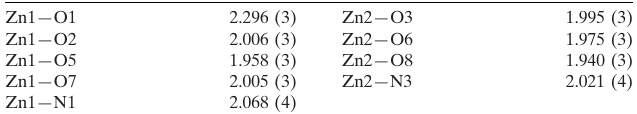
37814 measured reflections 10696 independent reflections int = 0.036 H atoms treated by a mixture of independent and constrained refinement (cid:2) (cid:7) max = 1.39 e A˚ (cid:4) 3